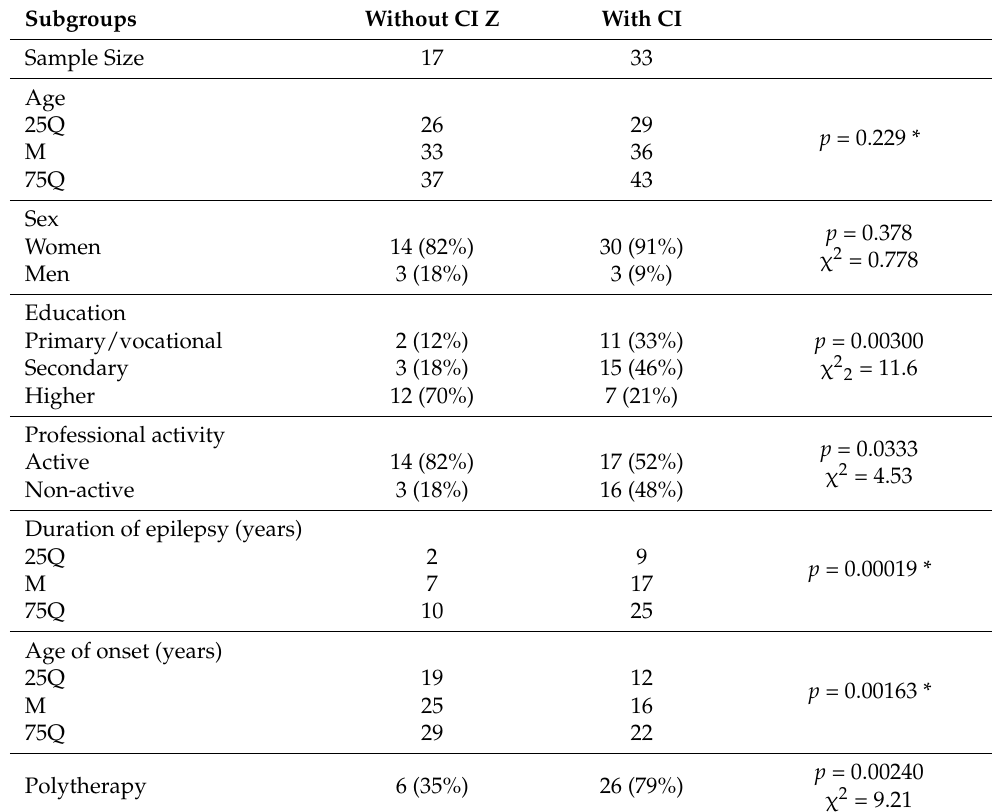
Table 3. Comparison of subgroups without cognitive impairment (1) and with cognitive impairment (2) with regard to demographic and clinical factors (25Q–25th quartile; M—median; 75Q–75th quartile). Subgroups Without CI Z With CI Sample